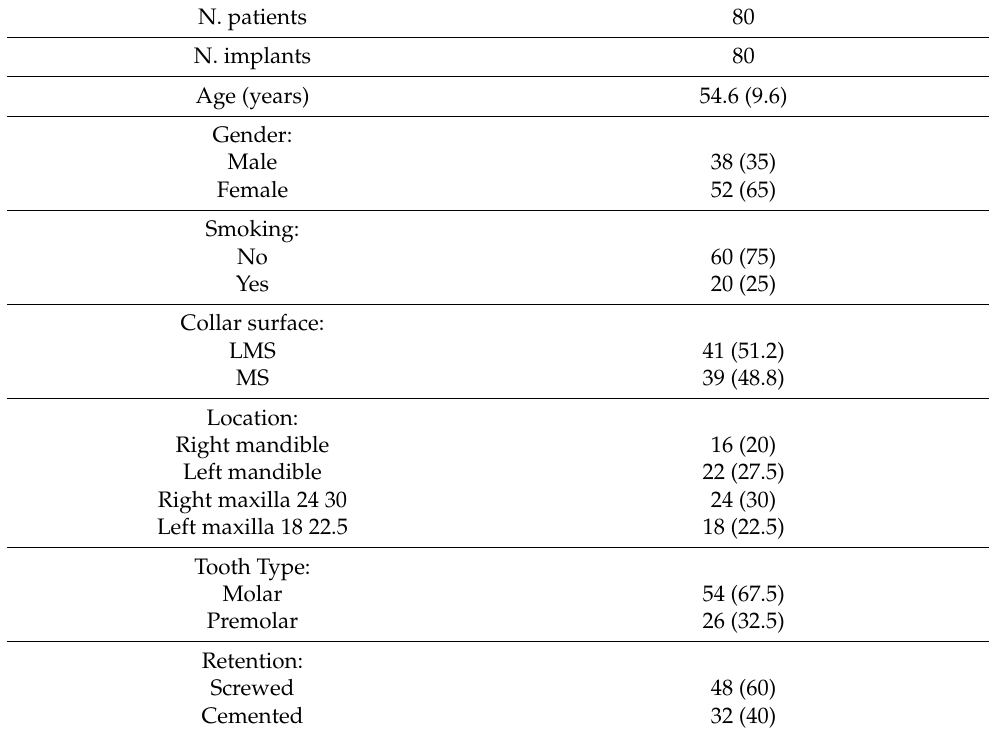
Table 1. Demographic and clinical characteristics